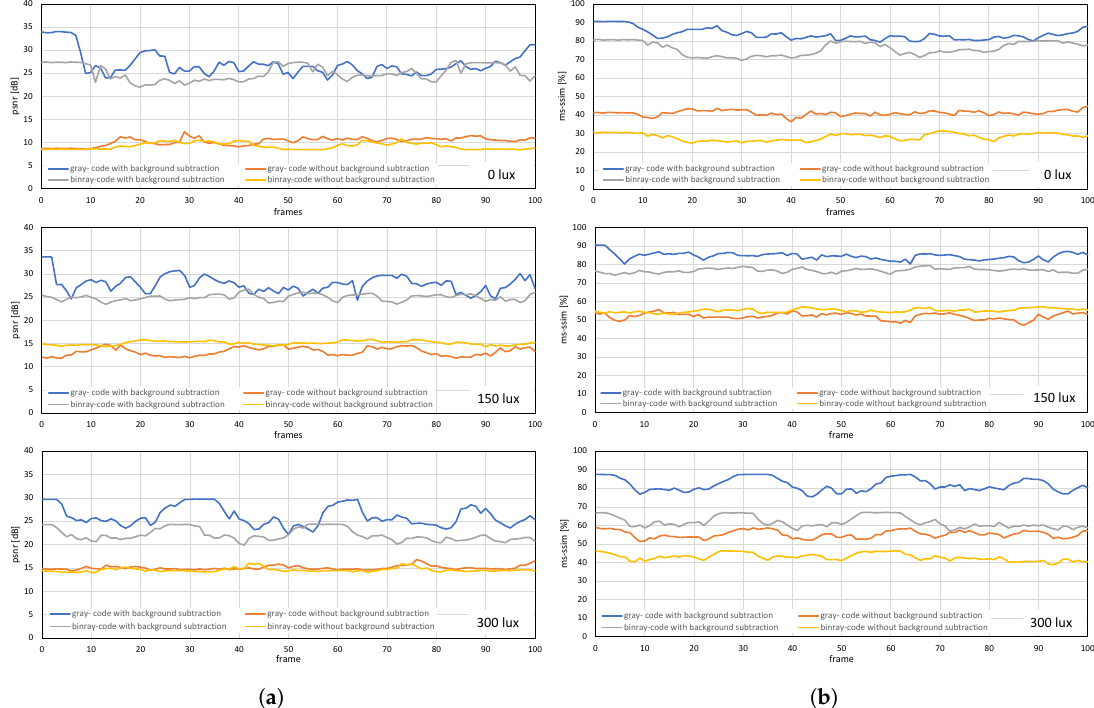
Figure 24. ( a ) PSNRs and ( b ) MS-SSIMs when USB camera video sequence is streamed with pure-binary-code and gray-code images on the patterned